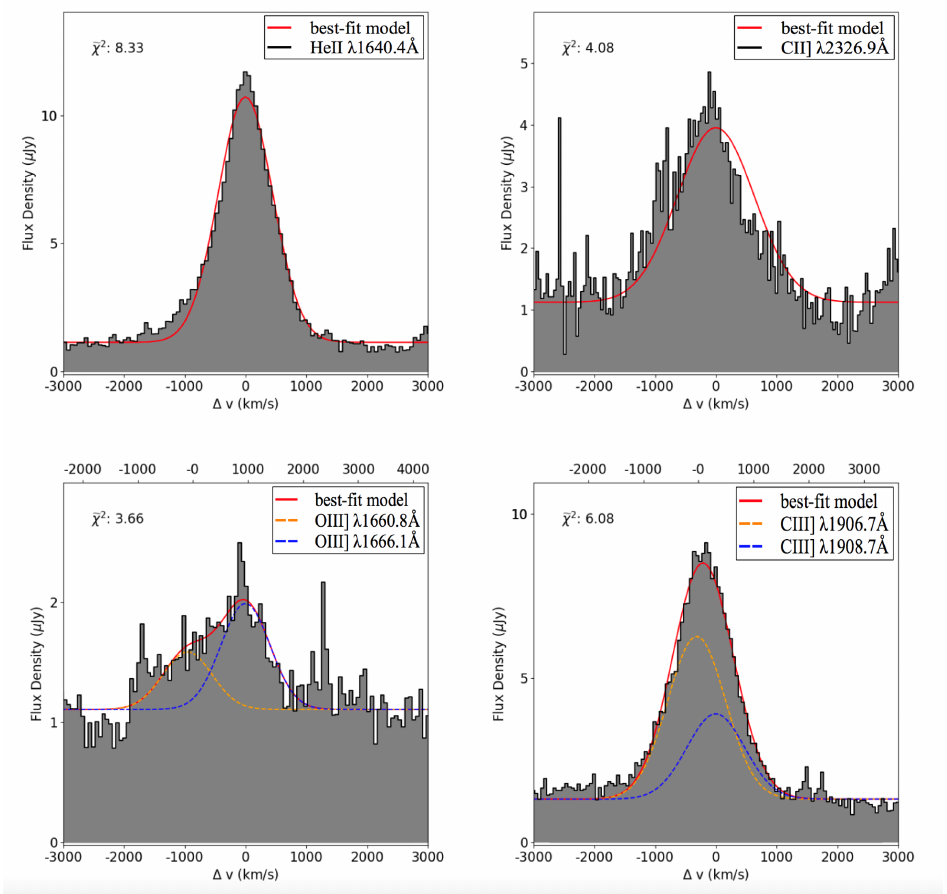
Figure 8. From Kolwa et al. in prep. Line emission from gas in the central 0.6 arcsec (4.75 kpc) of MRC 0943-242. This gas is ionized by the local AGN radiation field. Line widths larger than 1000 km s − 1 suggest a turbulent medium. For the top two figures the red profiles are best-fit single Gaussians. For the bottom two figures the doublets are fit with identical redshift. For the bottom two figures, the velocity scale of the bottom ( top ) horizontal axis is set to zero at the blue (orange) Gaussian